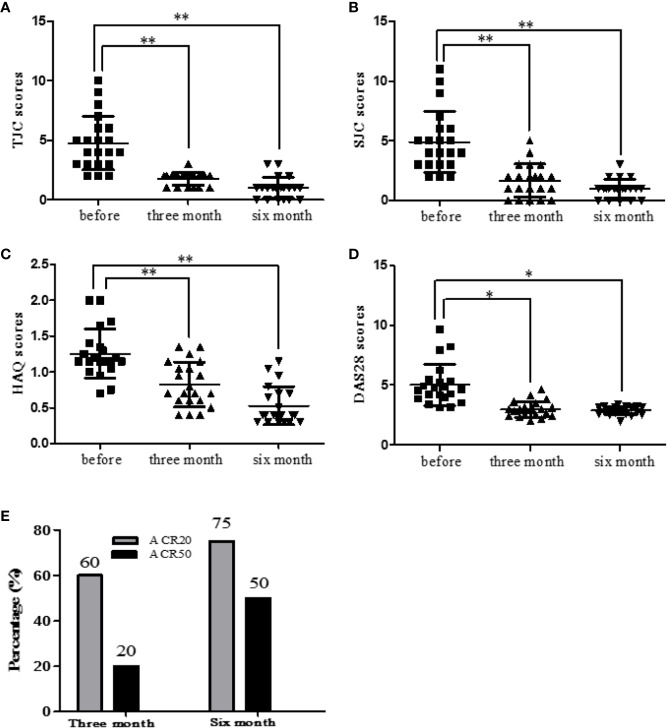
Etanercept down-regulates clinical indicators (HAQ, SJC, TJC, and DAS28) in patients with RA. (A) Change in the level of TJC scores after etanercept treatment. (B) Change in the level of SJC scores after etanercept treatment. (C) Change in the level of HAQ scores after etanercept treatment. (D) Change in the level of DAS28 scores after etanercept treatment. (E) Treatment with etanercept, the percentage of RA patients who have improved to ACR20 and ACR50 standards. *p < 0.05, **p < 0.01.